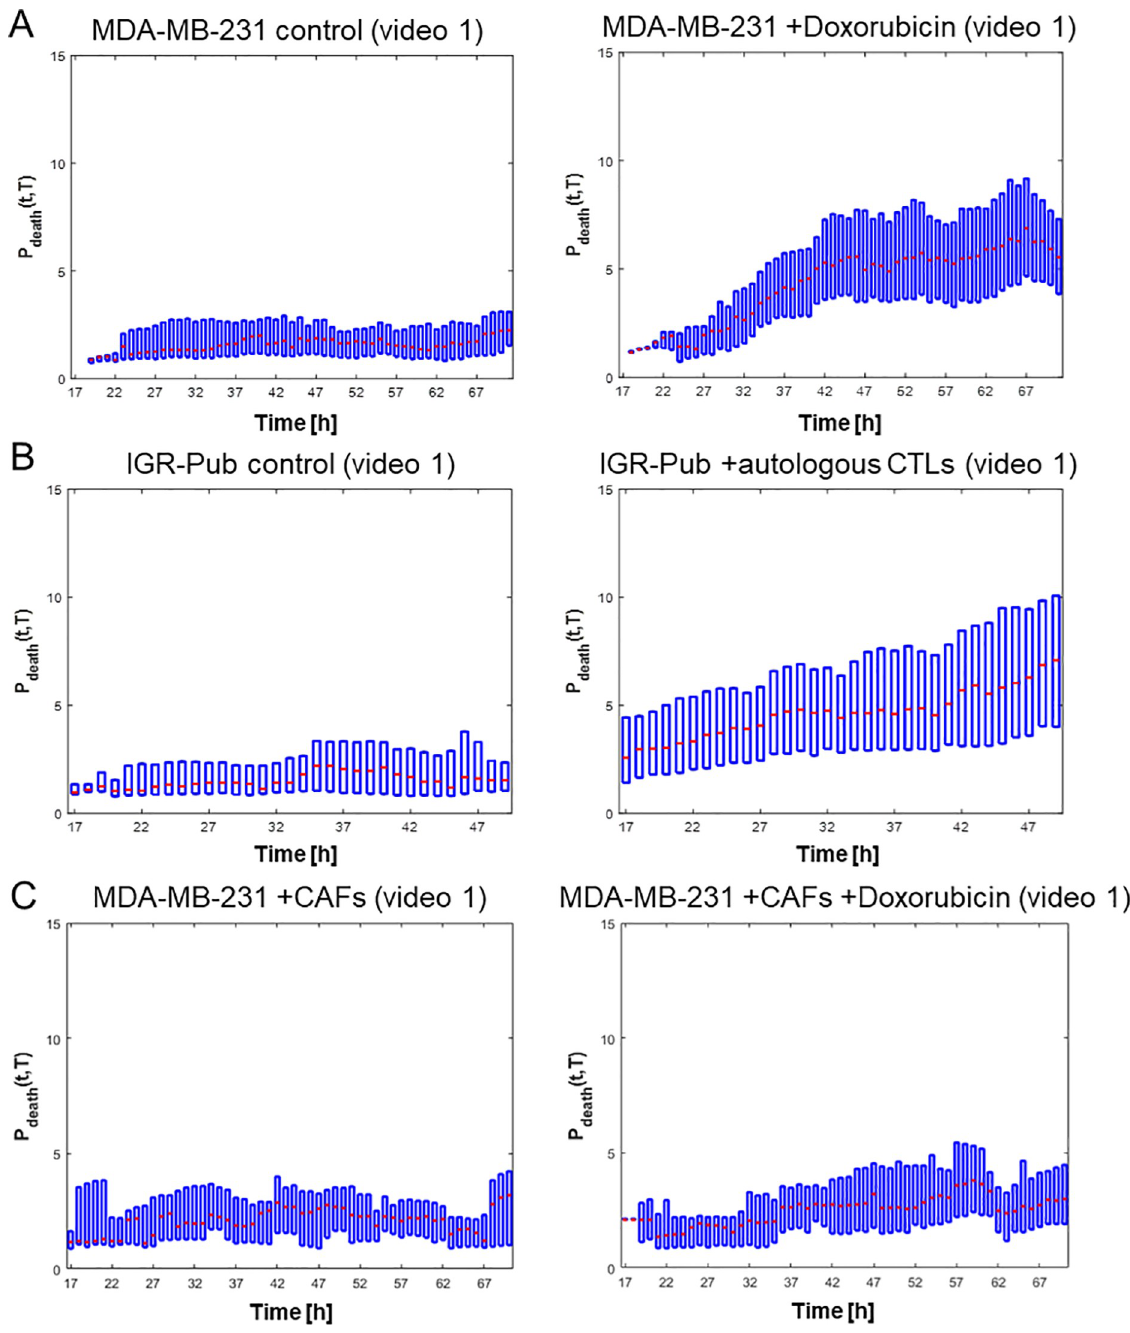
Fig 6. The Potential of death induction ( P ) of cancer cells increases over time upon cytotoxic death, but not upon natural death. A. death Representative P death analysis on one video of breast cancer MDA-MB-231 cells cultured within ToC without (left, natural death) or with 1 μ M doxorubicin (right, cytotoxic death). B. Representative P death analysis on one video of NSCLC IGR-Pub cells cultured within ToC alone analysis on one video of (left, natural death) or together with autologous CTL (P62 clone) (right, cytotoxic death). C. Representative P death breast cancer MDA-MB-231 cells co-cultured with CAFs within ToC, without (left) or with 1 μ M doxorubicin (right). More video analyses on additional view fields are shown in S2